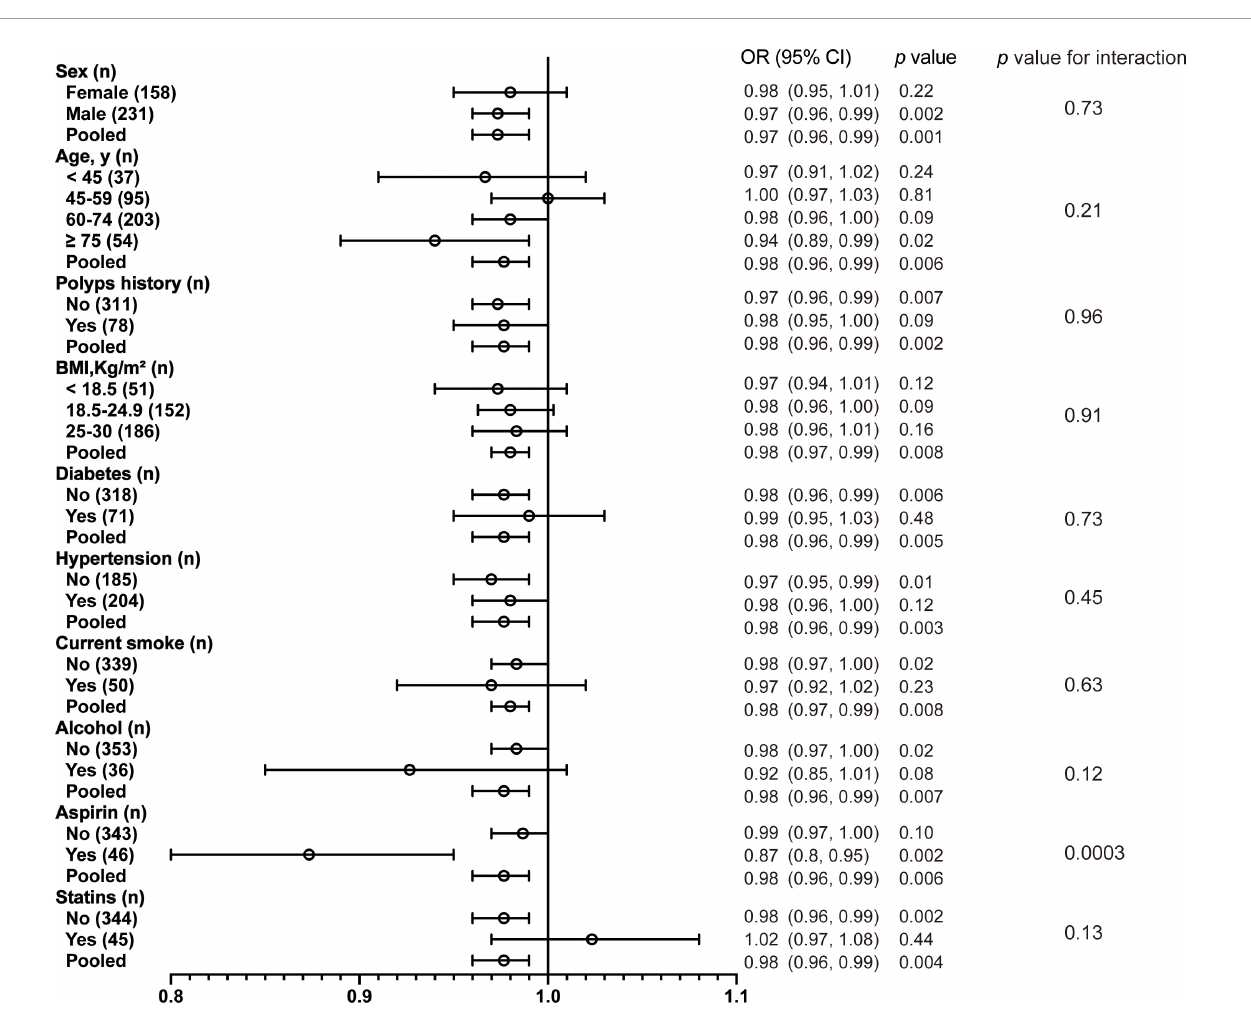
Frontiers in Nutrition